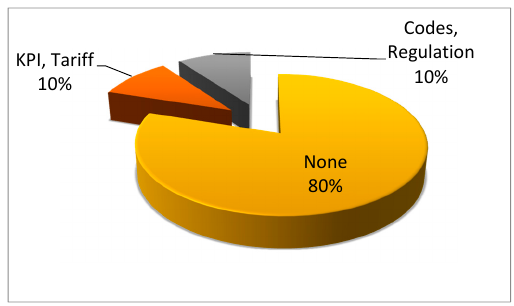
Figure 11. Opinions on the use of policy instruments according to the experts interviewed.